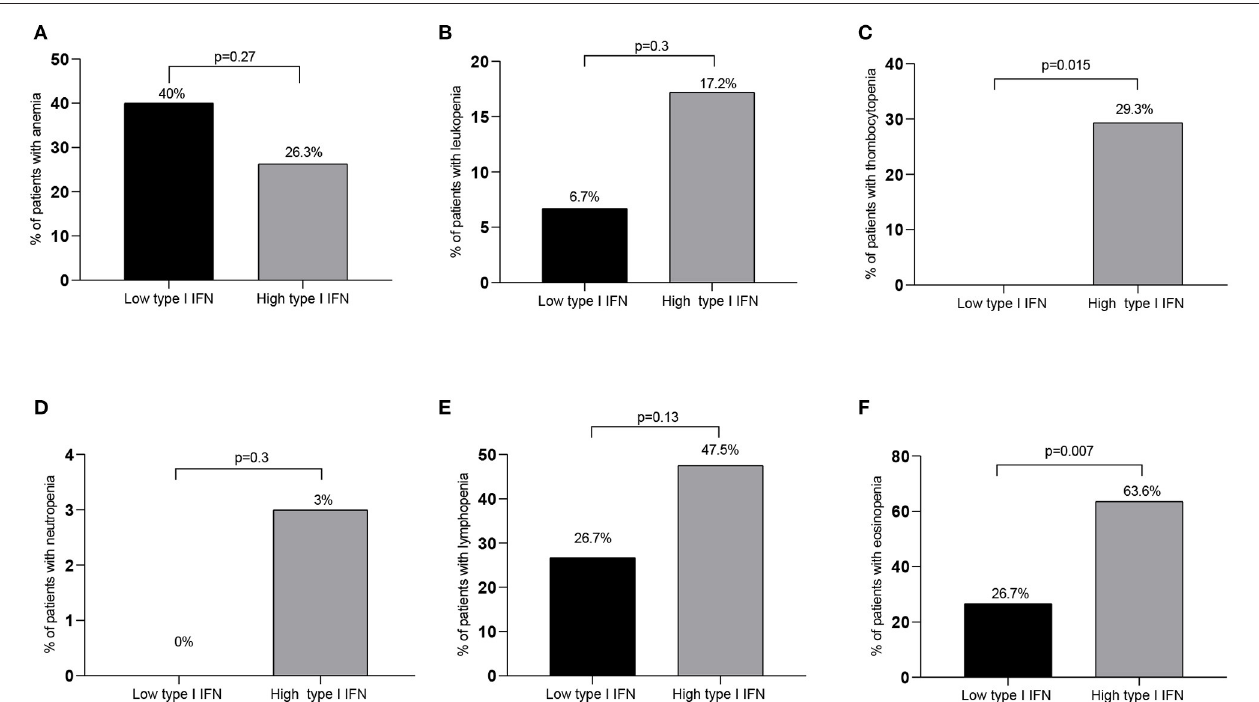
FIGURE 2 | Rates of hematological abnormalities among high vs. low IFN groups. While no significant differences between patient groups with high and low type I IFN peripheral blood scores were detected in the rates of anemia, leukopenia, neutropenia or lymphopenia [ (A,B,D,E) , respectively], significantly higher rates of thrombocytopenia and eosinopenia were detected in the high compared to the low type I IFN subset (C,F) . Only significant differences are shown. IFN, interferon; p ≤ 0.05 is considered